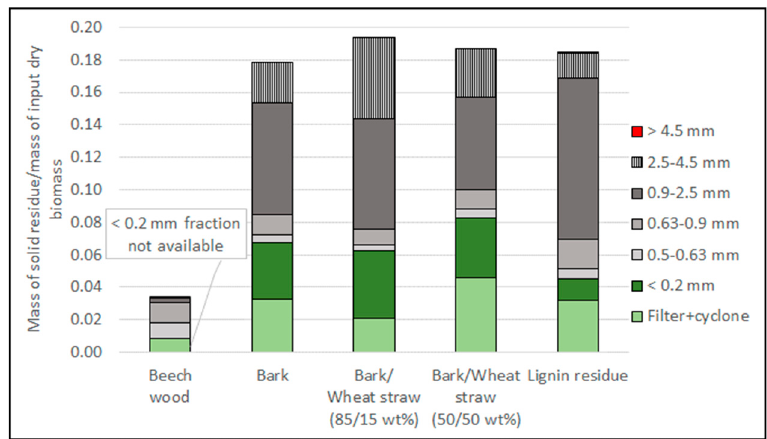
Figure 7. Mass ratio of solid residue over input dry biomass, as a function of residue particle class for each feedstock after gasification tests in fluidised bed.